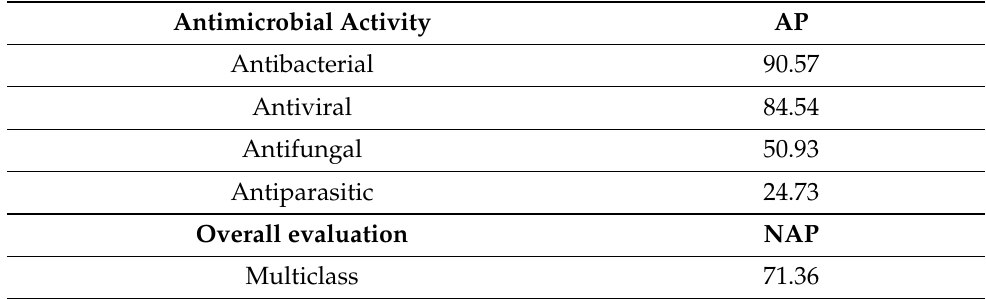
Table 6. Multilabel model